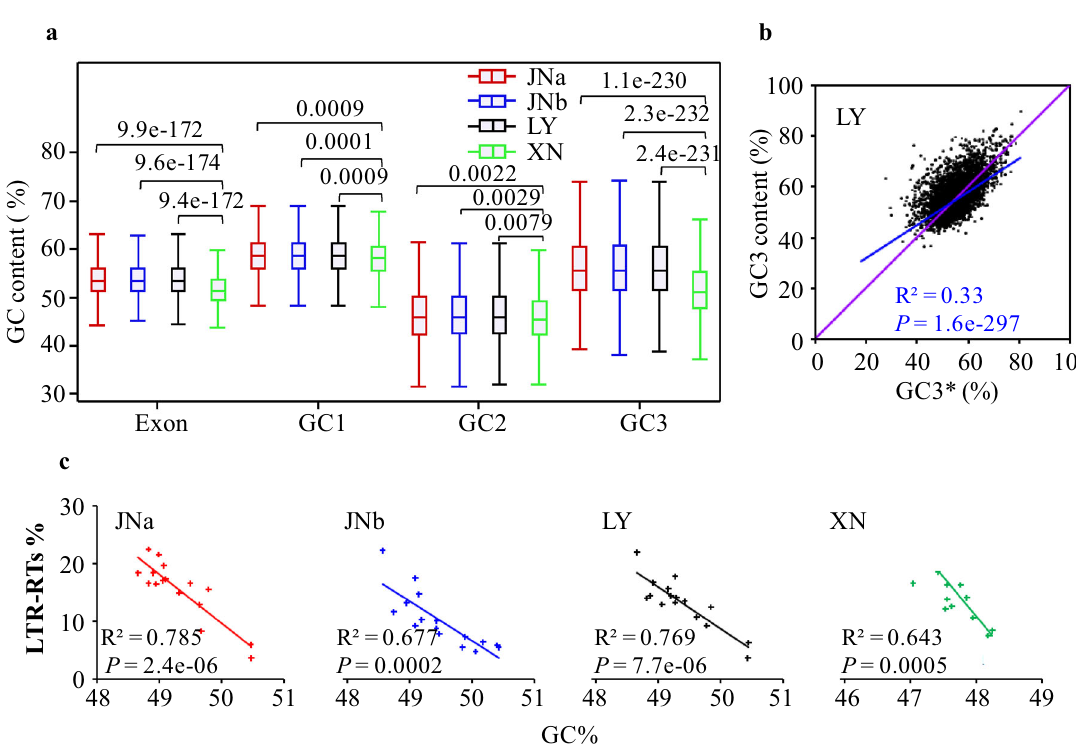
Fig. 7 Comparison of GC contents among JNa, JNb, LY, and XN. a The exonic GC content of XN orthologous genes (4,508) was markedly different from that of LY, JNa, or JNb, and the difference was predominant from the third codon positions (GC3) in relation to the fi rst (GC1) and second codon positions (GC2). The medians and the ranges were following: exon XN 51.36 (42.26 – 68.75), JNa 53.39 (44.07 – 70.38), JNb 53.44 (40.78 – 70.99), LY 53.38